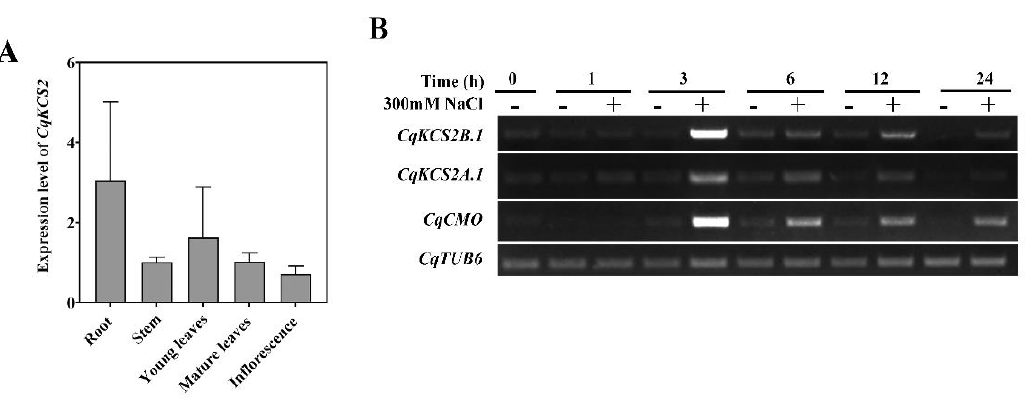
Figure 2. Transcript profile of CqKCS2A.1 and CqKCS2B.1 . ( A ) Detection of total CqKCS2 transcript levels in different tissues of quinoa: 1-month-old plant root, stem, leaves, mature plant leaves, and inflorescences. ( B ) Semi-quantitative RT-PCR analyses of CqKCS2A.1 and CqKCS2B.1 . Total RNA was extracted from 3-day-old quinoa seedlings grown in vitro and exposed to 300 mM NaCl for 0, 1, 3, 6, 12, and 24 h. In each case 1 µg total RNA was used as a template.